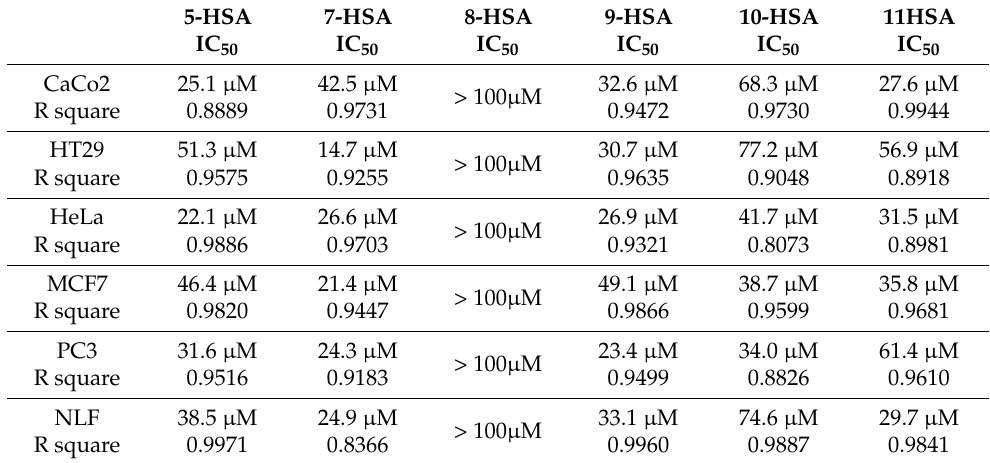
Table 1. IC 50 ( µ M) values of the HSA derivatives in the analyzed tumor cell